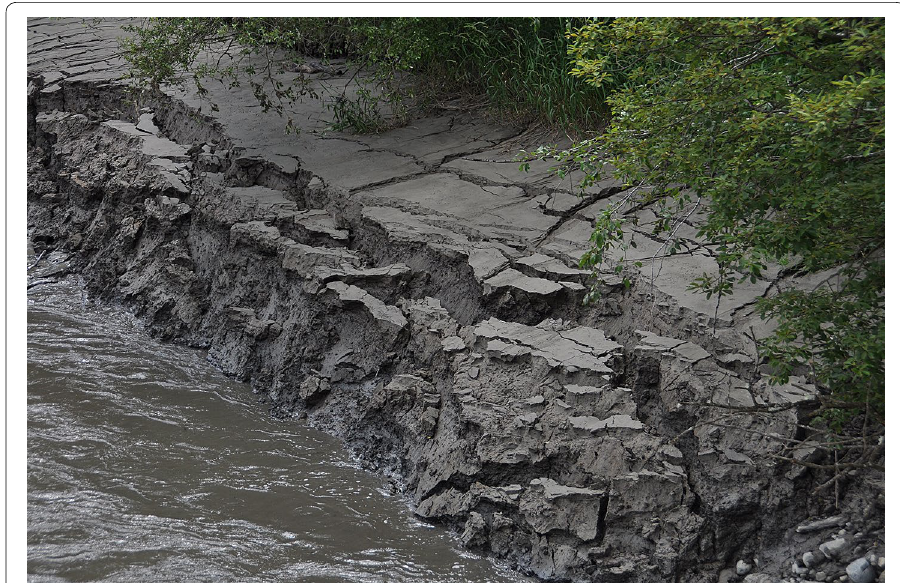
Fig. 12 Photograph of a sediment slide at the bank of the Bodendorf reservoir